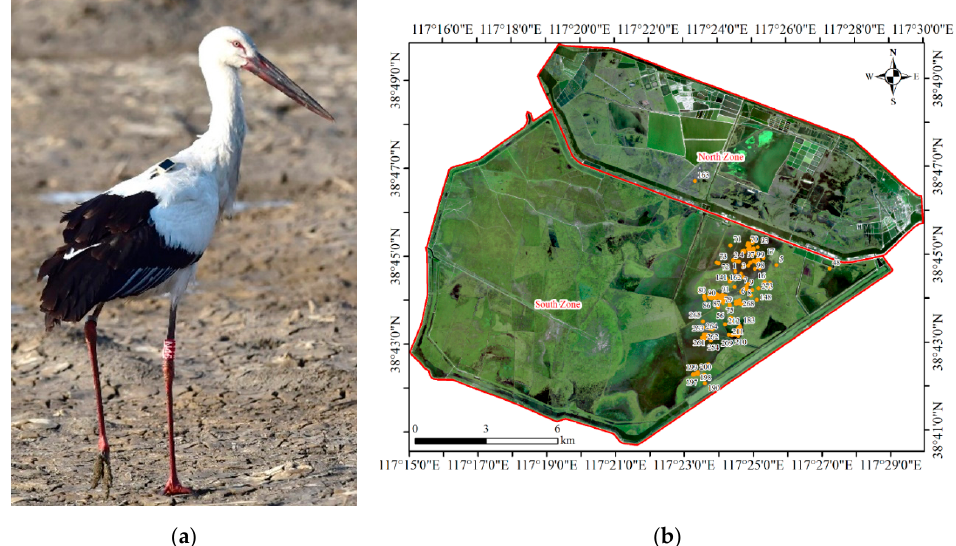
Figure 2. The rescued oriental white stork ( a ) and monitoring points in the spring ( b